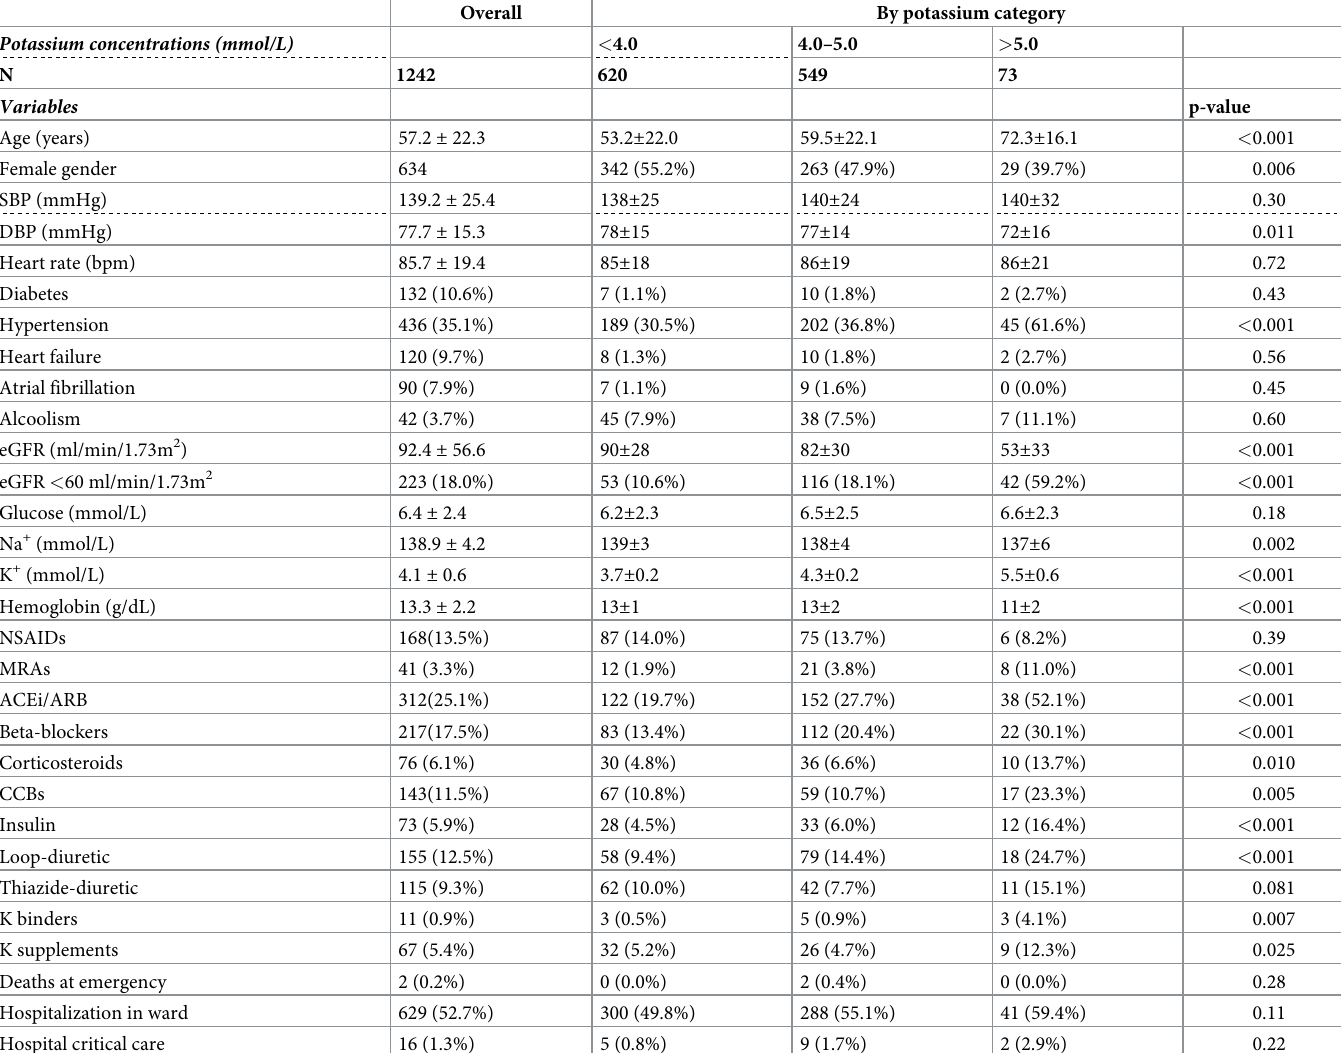
Table 1. Characteristics of the study population overall and by potassium level categories